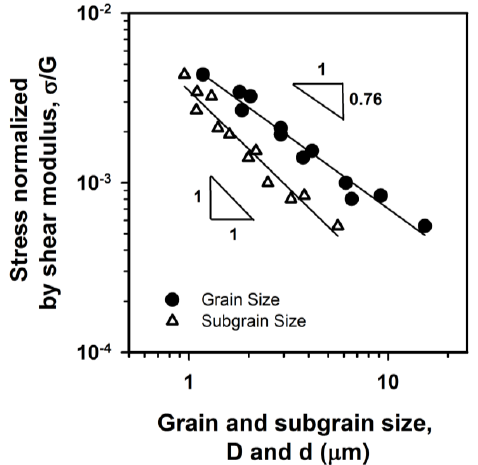
Figure 6. Relationship between the flow stress normalized by the shear modulus ( σ / G ) and the DRX grain size ( D ) and subgrain size ( d ) for the high-nitrogen austenitic stainless steel.